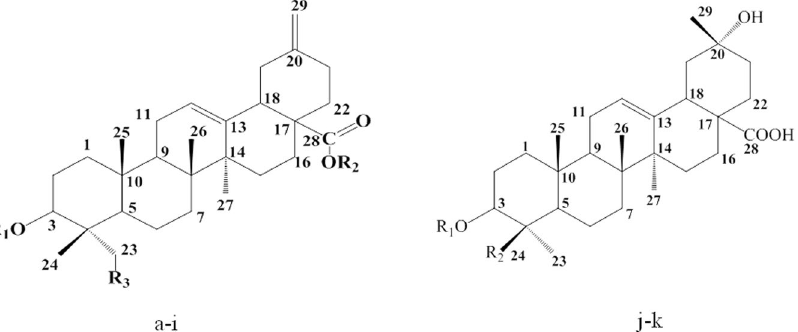
Figure 1. The structures of compounds isolated from the EtOH extracts of S. brachyanthera . (a) brachyantheraoside A1 R 1 = ara- R 2 = glc1-6glc- R 3 = OH. (b) brachyantheraoside A3 R 1 = glcaOMe 1 - 3 glc- R 2 = rha 1 - 4 glc 1 - 6 glc- R 3 = OH. (c) brachyantheraoside A4 R 1 = ara 1 - 4 ara 1 - 3 ara- R 2 = rha 1 - 4 glc 1 - 6 glc- R 3 = H. (d) brachyantheraoside A5 R 1 = ara 1 -(xyl 1 - 2 ) 3 ara 1 - 3 ara- R 2 = rha 1 - 4 glc 1 - 6 glc- R 3 = H. (e) YM7 R 1 = glc 1 - 3 rha 1 - 2 ara- R 2 = rha 1 - 4 glc 1 - 6 glc- R 3 = H. (f) YM9 R 1 = rha 1 - 2 ara- R 2 = rha 1 - 4 glc 1 - 6 glc- R 3 = H. (g) YM10 R 1 = ara- R 2 = glc 1 - 6 glc- R 3 = H. (h) YM11 R 1 = rha 1 - 2 ara- R 2 = glc 1 - 6 glc- R 3 = H. (i) YM13 R 1 = ara- R 2 = rha 1 - 4 glc 1 - 6 glc- R 3 = H. (j) brachyantheraoside B6 R 1 = H R 2 = rha 1 - 2 glc-O-. (k) brachyantheraoside B9 R 1 = ara 1 -(rha 1 - 2 ) 3 glc- R 2 =